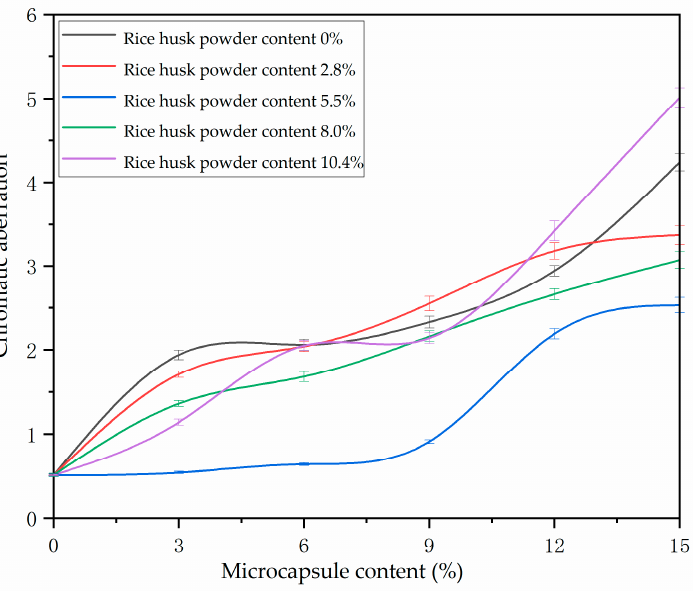
Figure 6. Effect of microcapsules with different contents of rice husk powder on the color differ- ence.